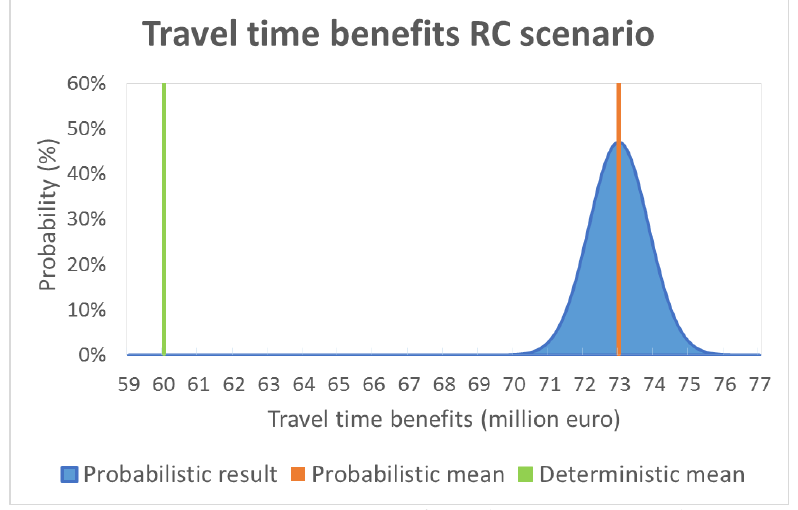
Figure 4. Uncertainty in estimations of travel time savings in the RC